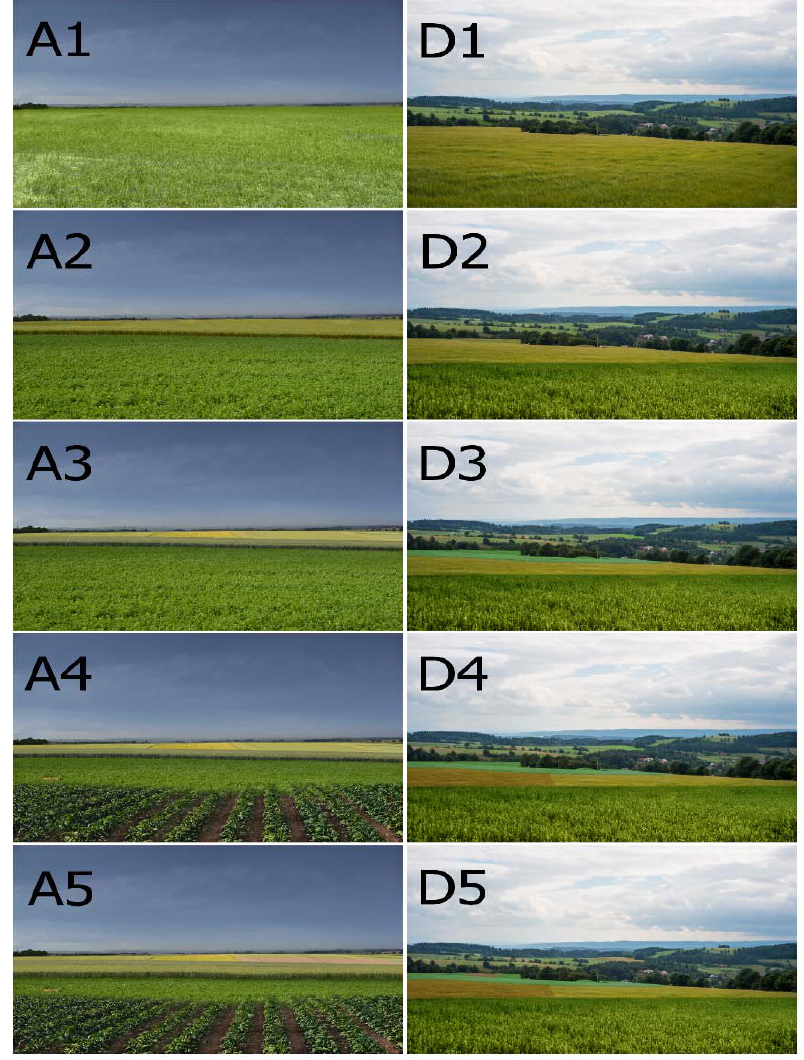
Figure 2. Landscapes A and D represent the landscape types with the lowest and highest baseline landscape heterogeneity, respectively. Each landscape is depicted in a series of five images according to the manipulated plot size, illustrated by a variety of crops with different colors and shapes. Plots of approximately 50 ha in size are part of landscapes (A1 and D1), followed by plots of about 35 ha in landscapes A2 and D2, 20 ha plots in landscapes A3 and D3, 10 ha plots in landscapes A4 and D4, and 5 ha plots in landscapes A5 and D5.